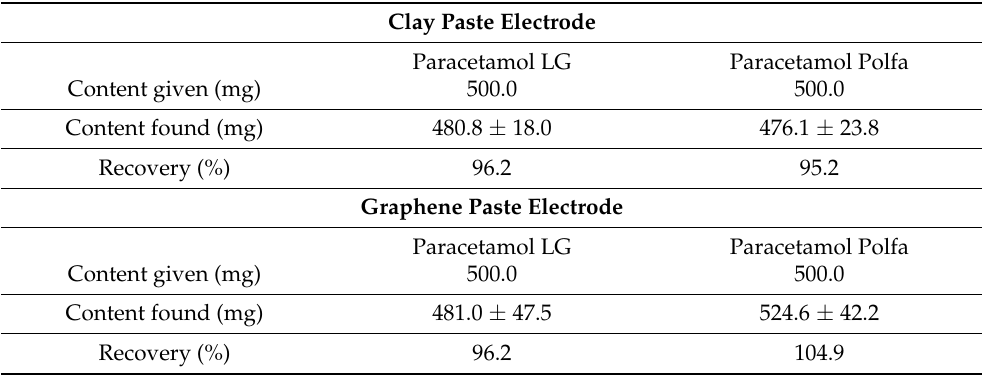
Table 2. Determination of PA in commercial formulations, n =